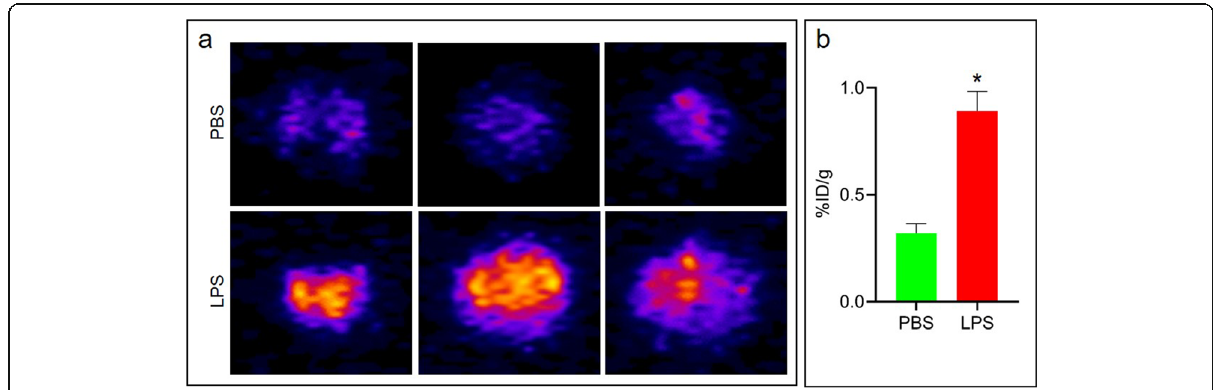
Fig. 5 a PET scans of dissected lungs from LPS ( n = 4) and PBS ( n = 3) treated mice ~ 4.5 h after 68 Ga-albumin injection. b quantification of uptake from ( a ). * p <